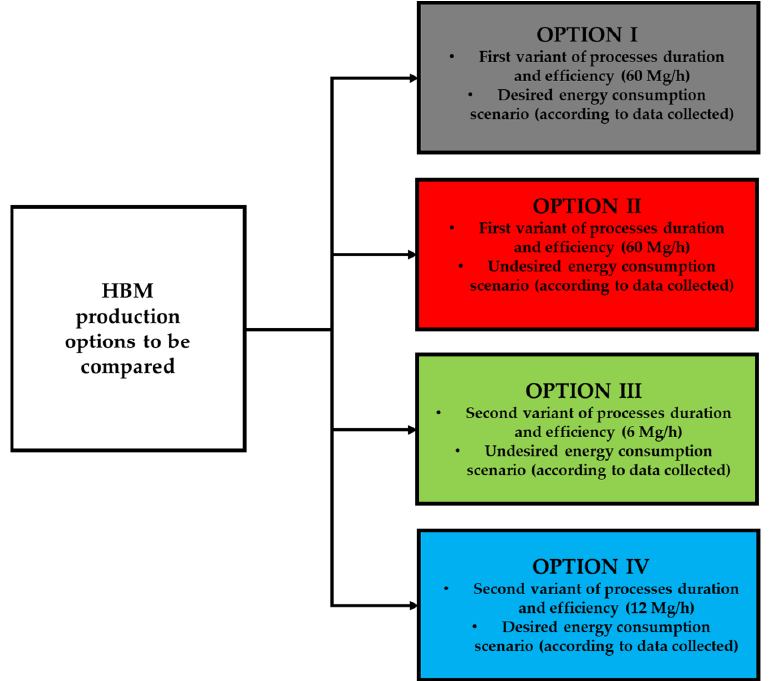
Figure 3. HBM lignite production options from a single borehole to be compared.